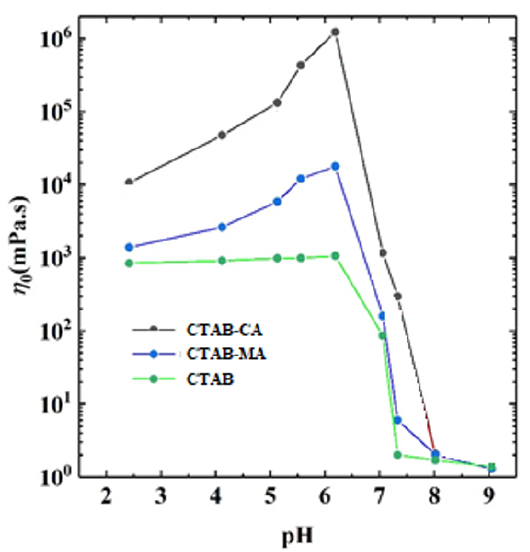
Figure 13. The apparent viscosity for the three types of CTAB based (CTAB, CTAB-MA, and CTAB-CA) VES-fluid at different pH-values, at constant low shear rate, and at 25 ◦ C.